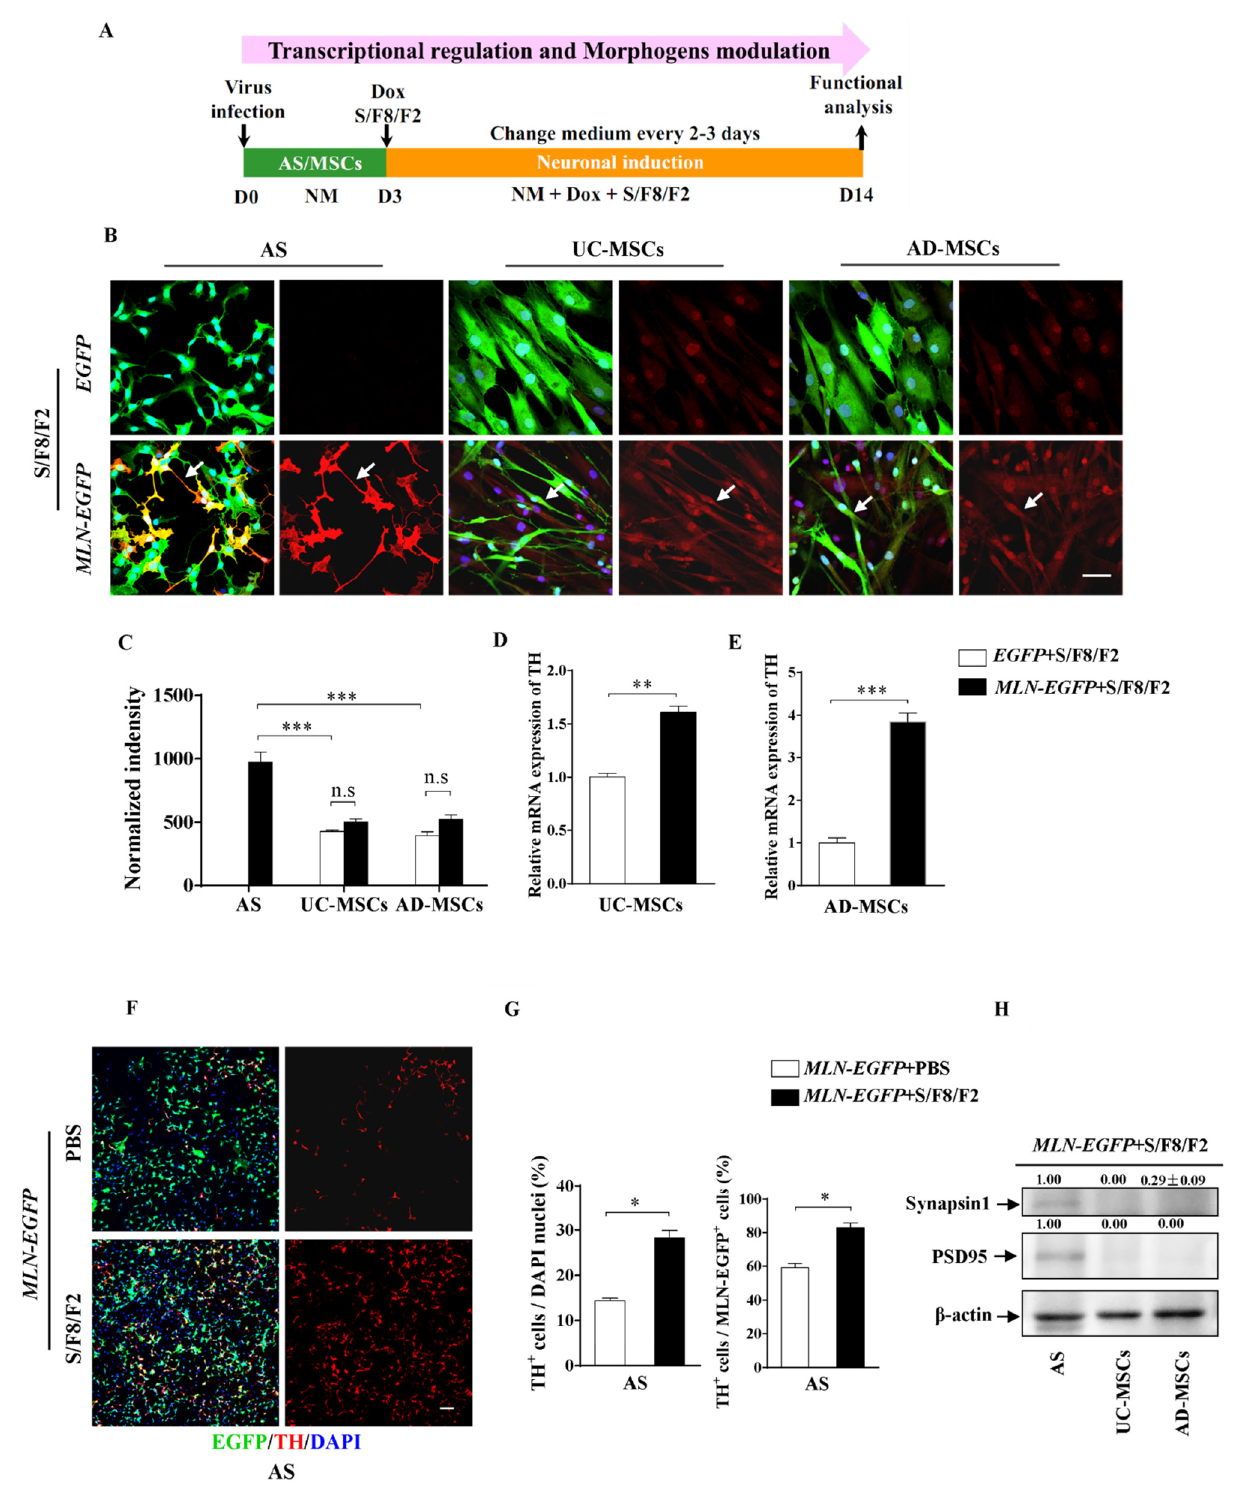
Figure 6. AS exhibited higher TH expression levels as compared to MSCs by the transcriptional and morphogenic activation. ( A ) The paradigm of DA induction by the transcriptional regulation and the morphogenic activation. AS, UC-MSCs, or AD-MSCs were infected with lentivirus carrying MLN-EGFP or EGFP (control) and then treated with NM containing Dox and morphogens S/F8/F2 to initiate both the transcriptional and morphogenic induction for 14 days. On the 14th day, cells were fixed and stained for double staining of TH and EGFP, and the representative confocal images were shown in ( B , F ) (B, AS; UC-MSCs; AD-MSCs). DAPI was used as counterstaining. Note that TH-positive cells with more typical neuronal morphology (indicated with white arrows) could be observed in the AS, UC-MSCs and AD-MSCs treated sim- ultaneously with MLN cocktail and S/F8/F2 (The lower panels in B). ( C – E ) Quantified data showed the expression level of